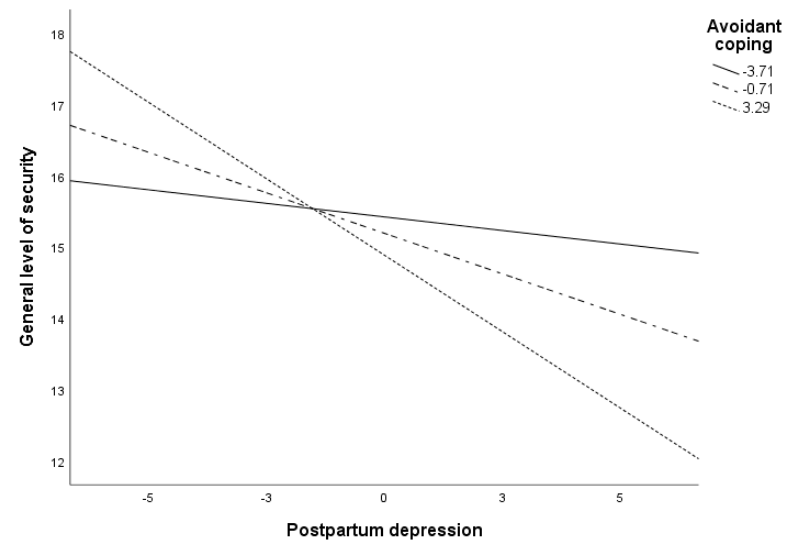
and general safety level. Specifically, PPD was negatively associated with maternal safety when avoidant coping was high or medium ( p < 0.001). When avoidant coping was low, the relationship between PPD and general safety was not significant.